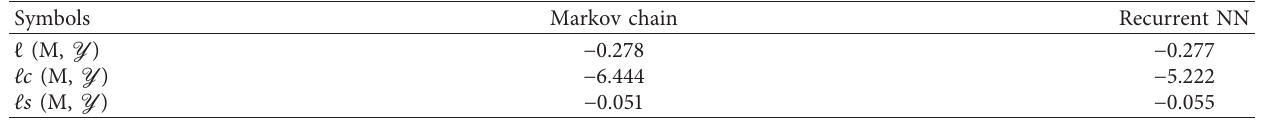
Table 3: Average log probabilities of the models on the test set. Symbols